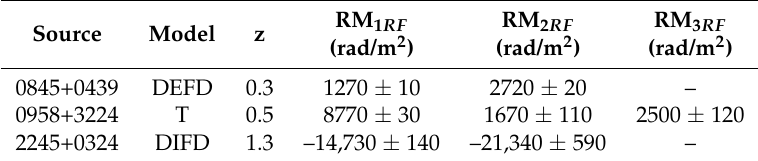
Table 1. RM values of the modelling corrected to the rest frame (subscript